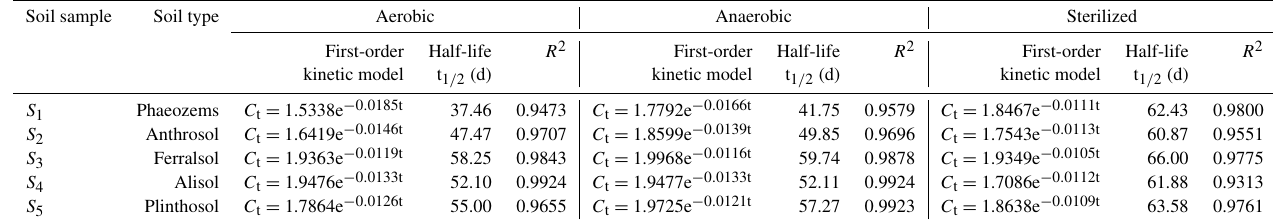
Figure 2. Degradation kinetics of EPM under aerobic (a) , anaerobic (b) , and sterilization (c) conditions with 60% moisture, under aerobic conditions with 40% moisture (d) , and with 80% moisture (e) in five different agricultural soils ( S 1 to S 5 are defined in Table 1). Values are the means ± standard error ( n = 3). Table 3. Degradation kinetic models and parameters of EPM under different conditions. Soil sample Soil